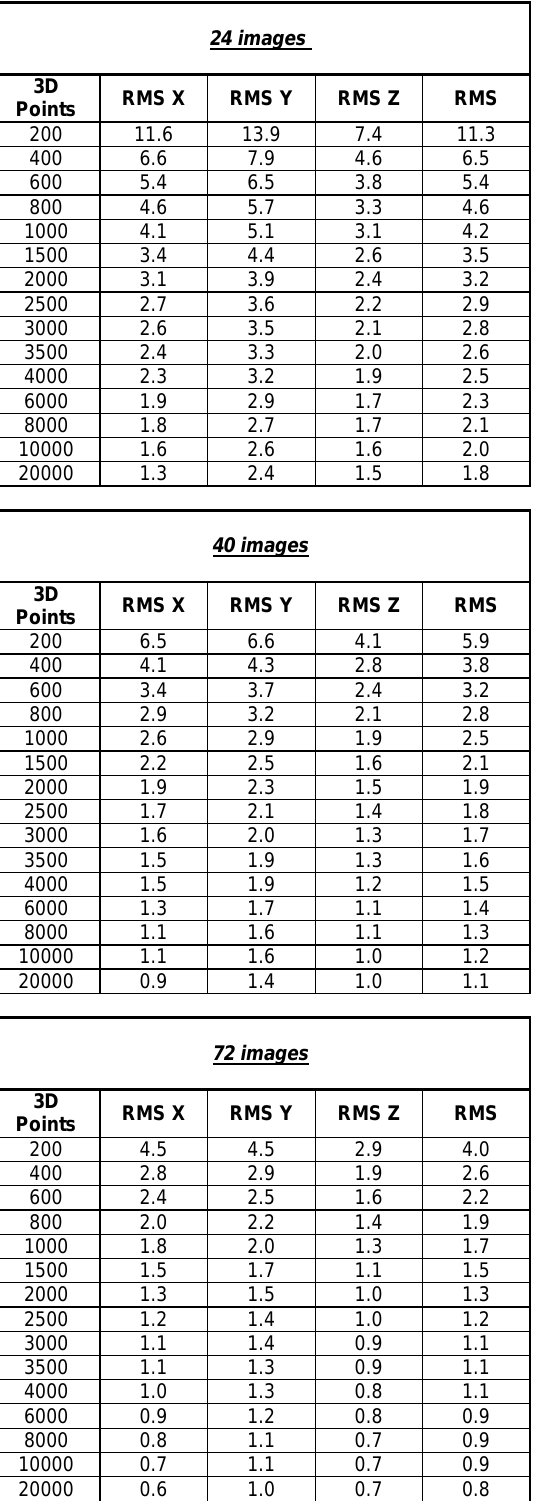
Figure 4. Image configuration for a closed sequence. Point normals are needed to determine object